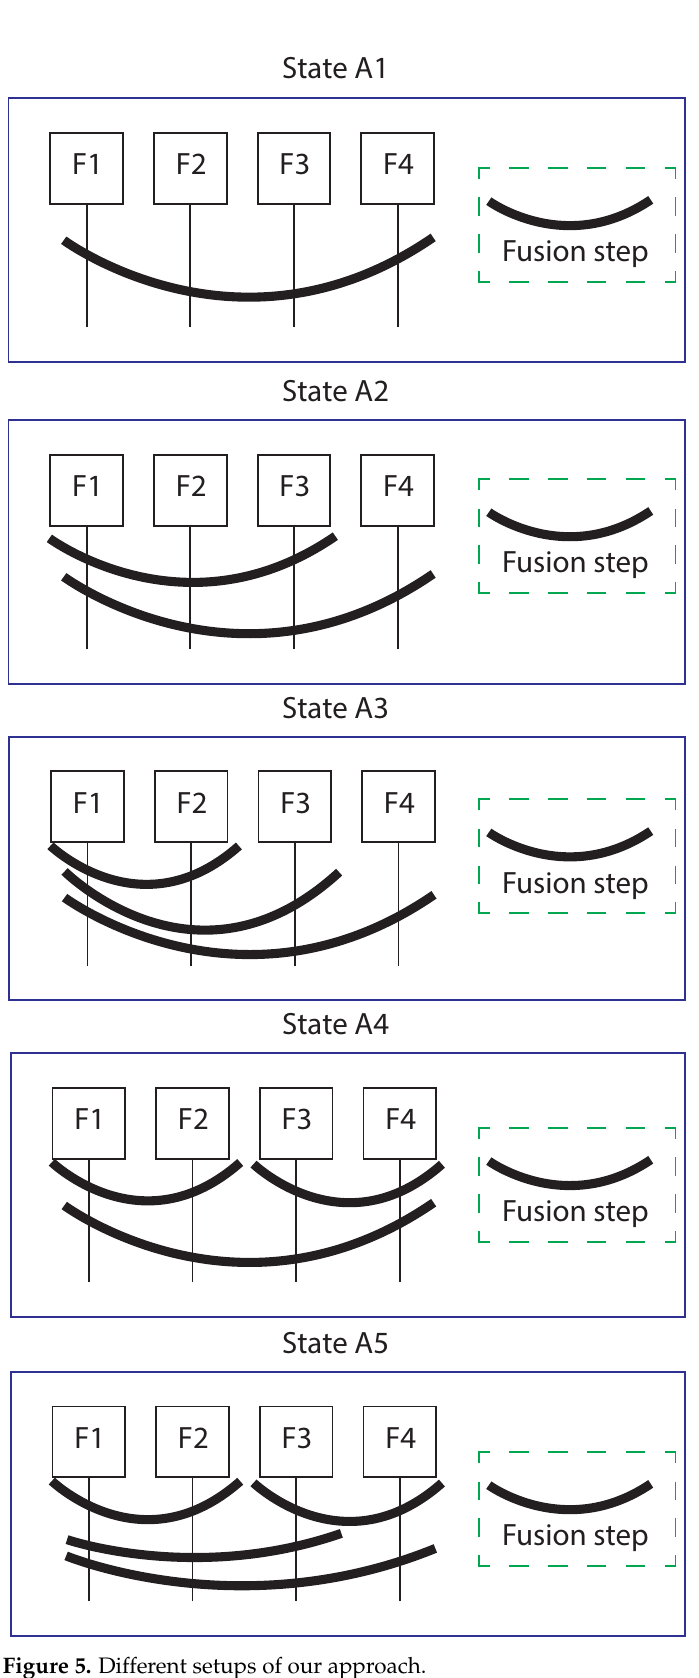
Figure 5. Different setups of our